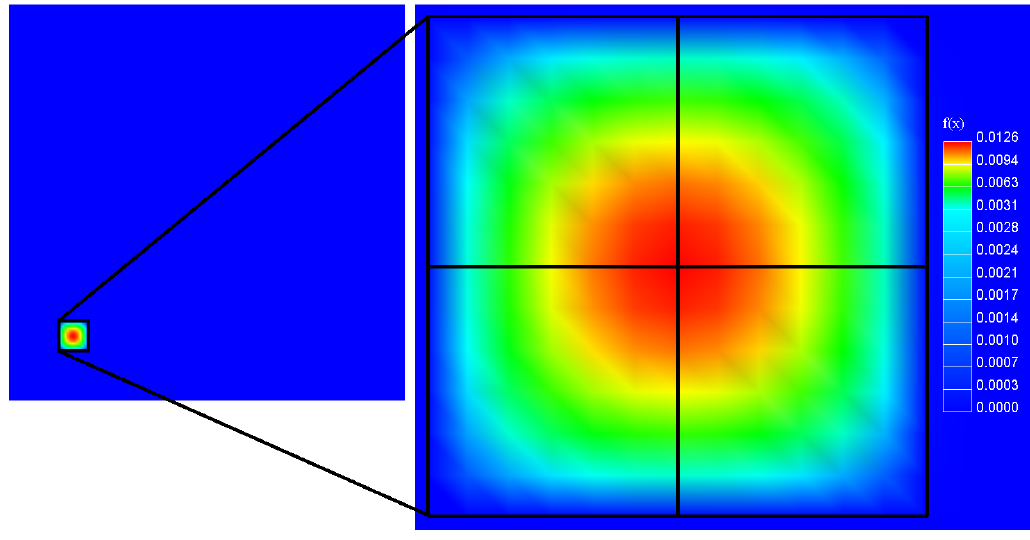
Figure 5. Zoom-in the given hat-function.